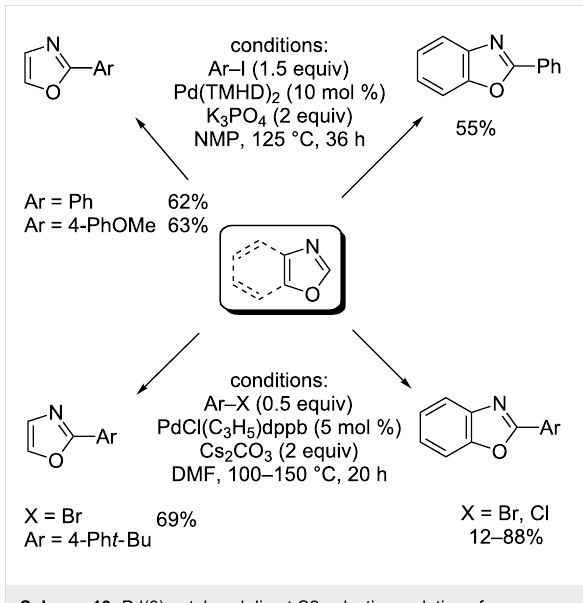
Bhanage proposed the use of 2,2,6,6-tetramethyl-3,5-heptane- dione ligand (TMHD) to achieve regioselective, Pd(0)- catalyzed, direct arylation of N -methylindole, thiazoles and oxazoles, using phosphate or carbonate bases (Scheme 13) [55]. The same year, Doucet demonstrated the high efficiency of arylation of thiazoles and oxazoles with arylbromides (Scheme 13) [56]. Notably under these two protocols, oxazole was monoarylated selectively at the C2 position in 62% and 69% yields,